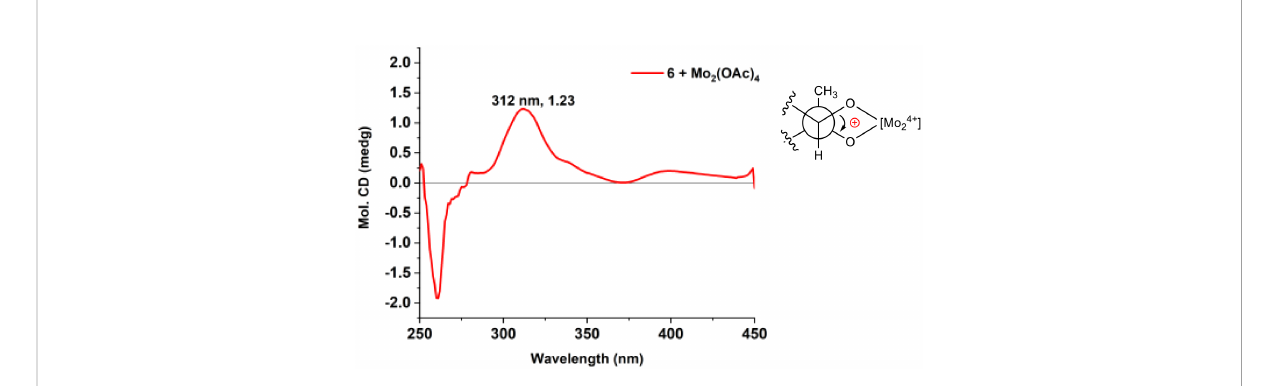
FIGURE 5 ECD spectrum of 6 in DMSO containing Mo 2 (OAc) 4 with the inherent ECD spectrum subtracted.